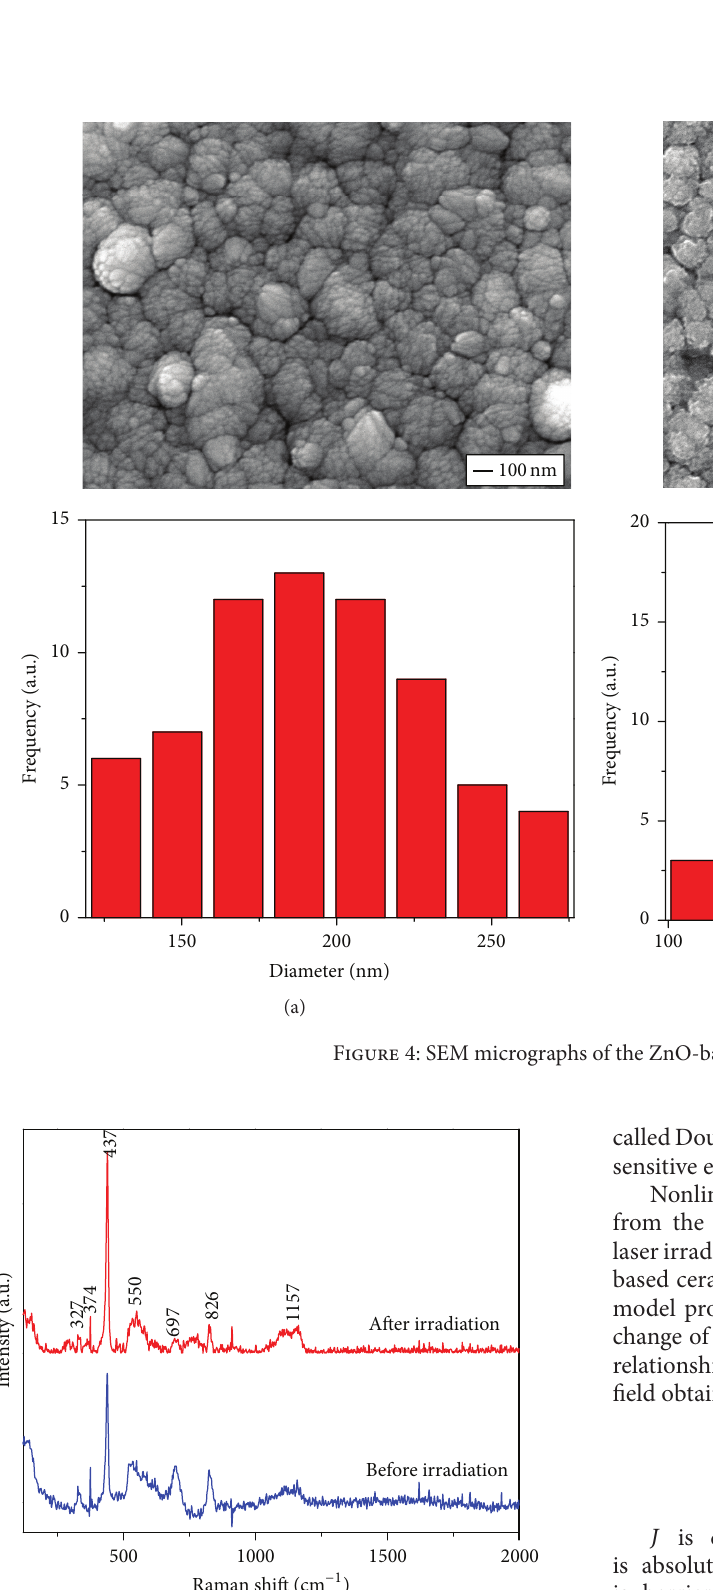
depleted, and depletion layers are formed. Consequently, electronic barriers with certain depth have been formed from grain surfaces into body. The barrier height is Φ 𝐵 , which